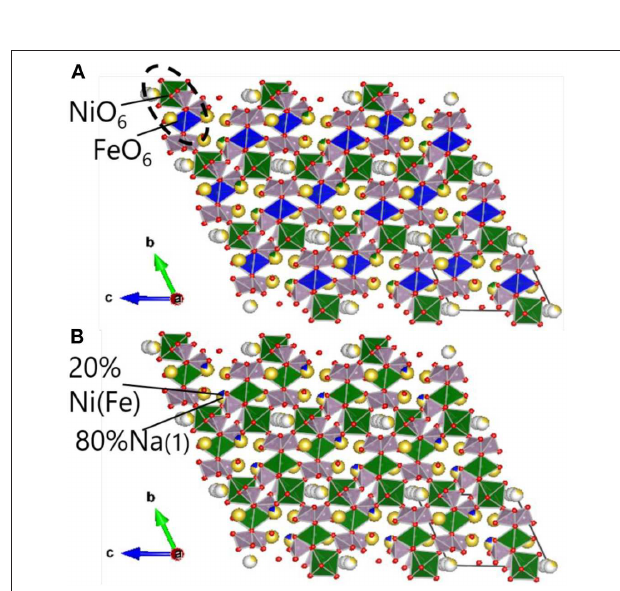
FIGURE 7 | Crystal structure of Na 2 Fe x Ni 1 − x P 2 O 7 , (A) Ni-Fe substitution type 1; (B) Ni-Fe substitution type 2. Na (yellow), Fe (blue), Ni (green), P (purple), O